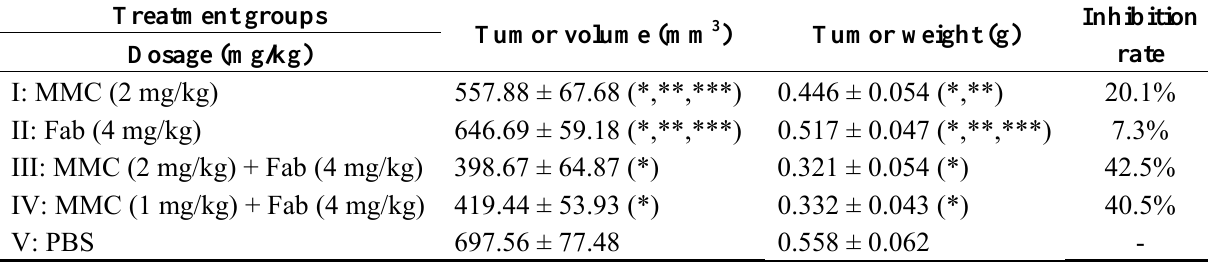
Table 1. The inhibitory effects of mitomycin C (MMC) and Fab on NPC xenograft tumor growth in vivo . Data were expressed as Mean ± SD ( n = 6 for group I; n = 8 for group II–V). * P < 0.001 vs. group V; ** P < 0.05 vs. group III; *** P < 0.05 vs. group